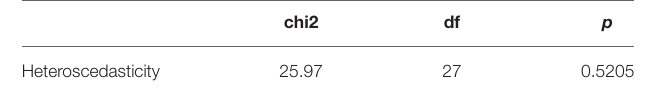
TABLE 4 | White test for heteroscedasticity.